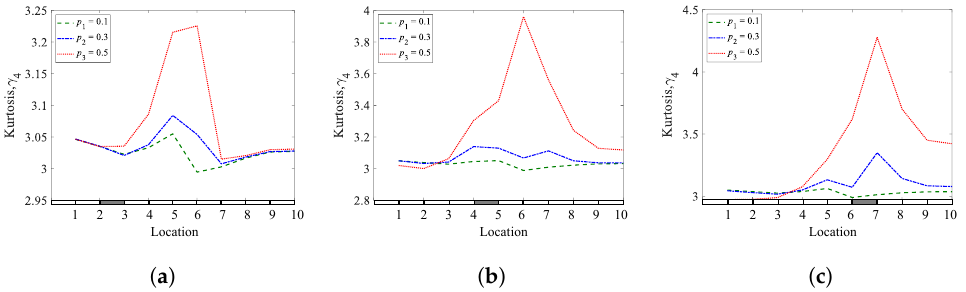
Figure 14. Kurtosis coefficients of a cantilever, simply supported beam for different crack depths and locations: ( a ) q 1 = 0.25; ( b ) q 2 = 0.45; ( c ) q 3 = 0.65.